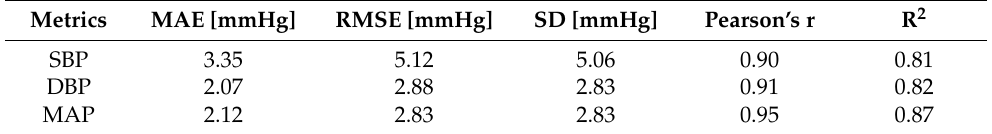
Table 11. Evaluation metrics for SBP, DBP, and MAP.